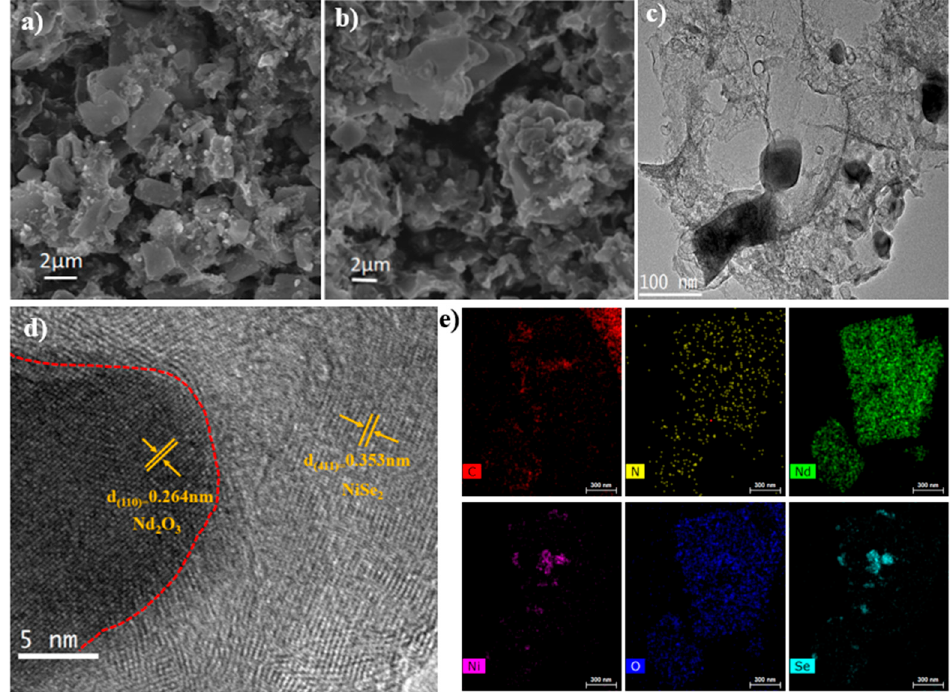
Figure 2. ( a , b ) SEM images of Nd 2 O 3 -NiSe 2 -450 ◦ C-NC at pre-selenide and post-selenide; ( c ) TEM images of Nd 2 O 3 -NiSe 2 -450 ◦ C-NC; ( d ) HR-TEM images of Nd 2 O 3 -NiSe 2 -450 ◦ C-NC; ( e ) elemental mapping of Nd 2 O 3 -NiSe 2 -450 ◦ C-NC (scale bar = 300